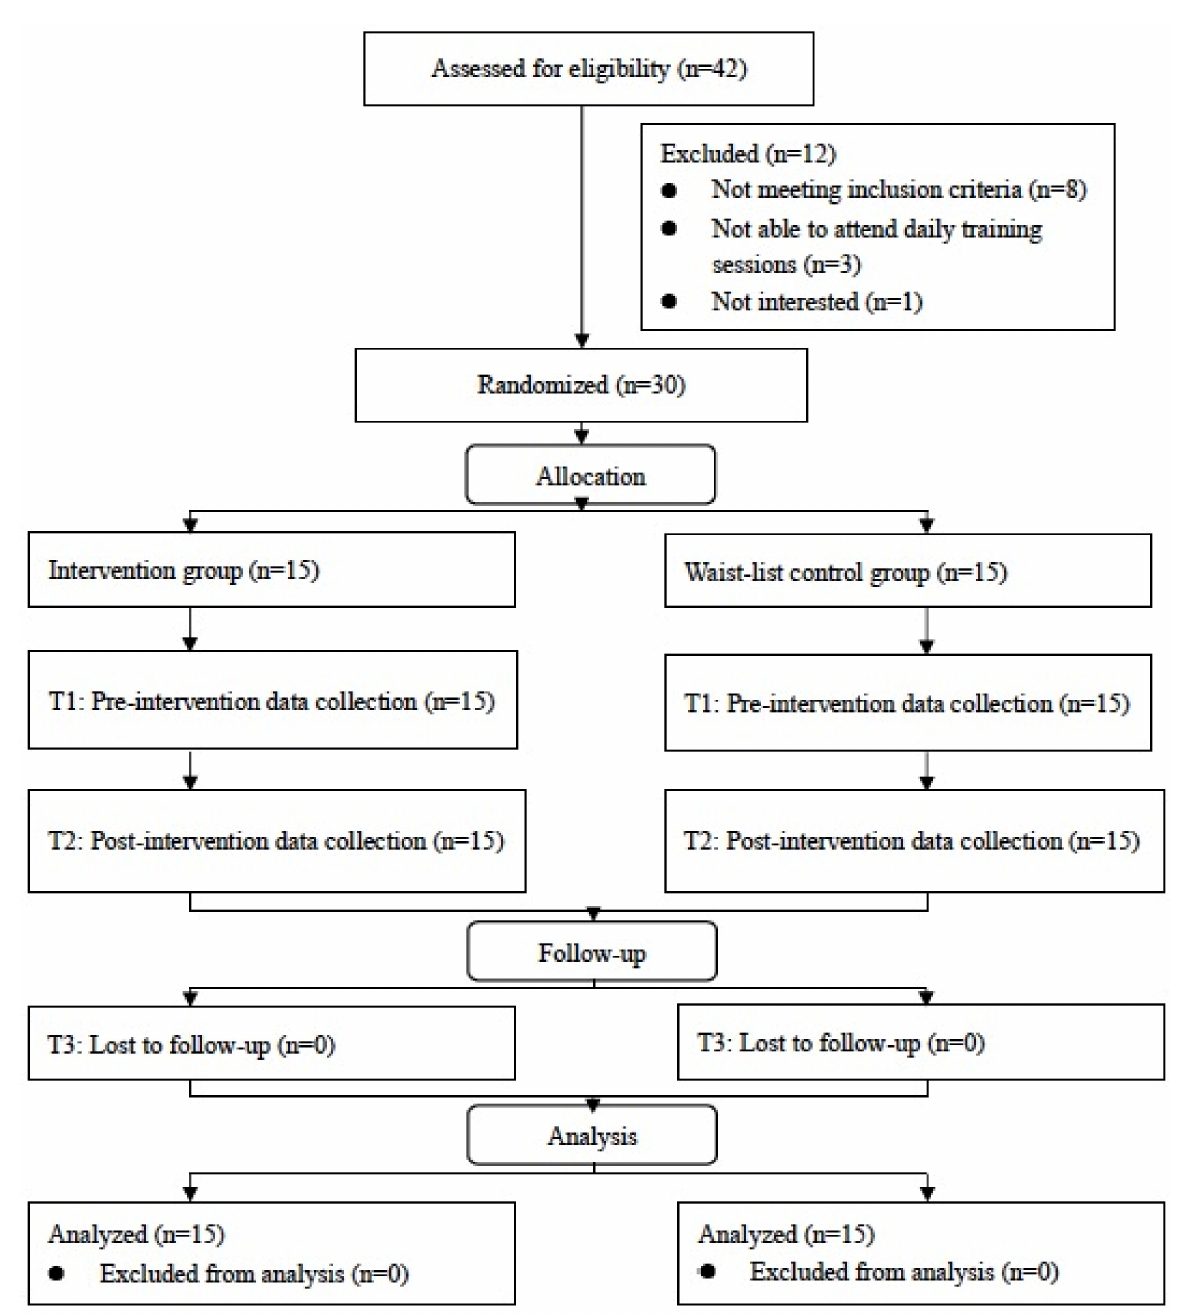
Figure 1. Participant flow diagram in CONSORT